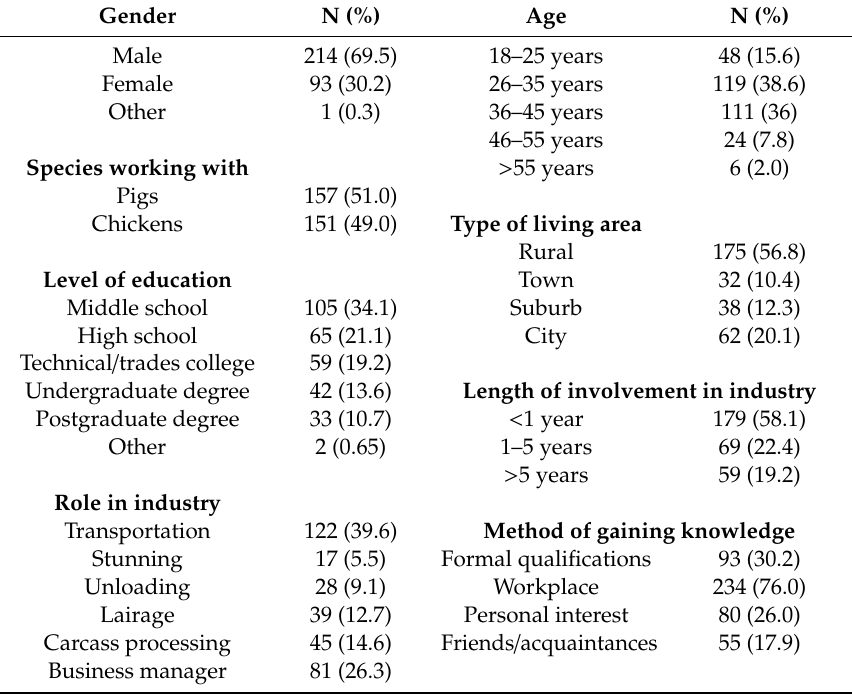
Table 1. Demographic information of respondents and assessment of animal welfare of all stakeholders completing the survey ( n = 308). Where percentages sum to less than 100, some answers were blank or not valid. Where percentages sum to more than 100, respondents could choose more than one